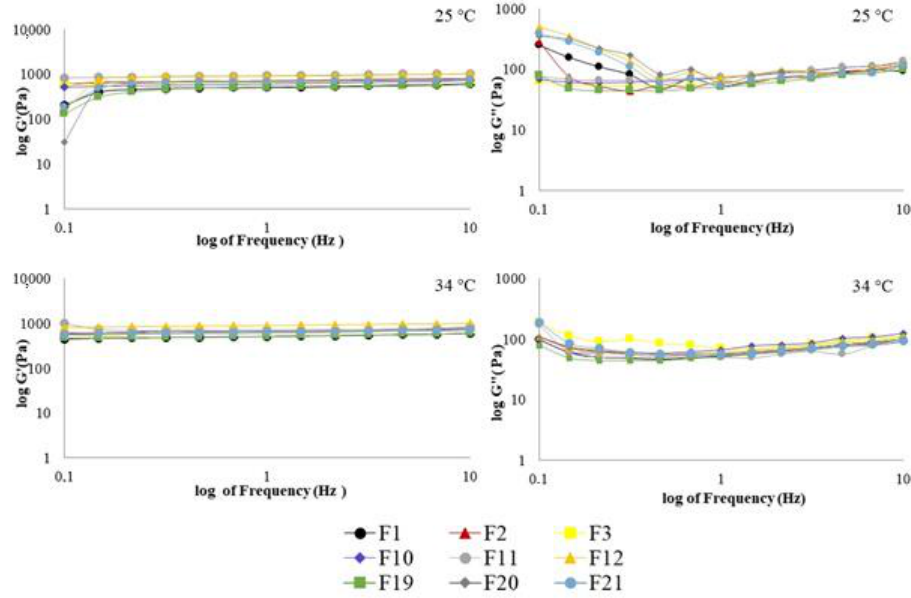
Figure 7. Elastic modulus (G’) and viscous modulus (G”) as a function of frequency of formulations containing PF oil. Each point is the mean of at least three replicates. Standard deviations have been omitted for clarity; however, in all cases, the relative standard deviation of replicate analysis was less than 10%.